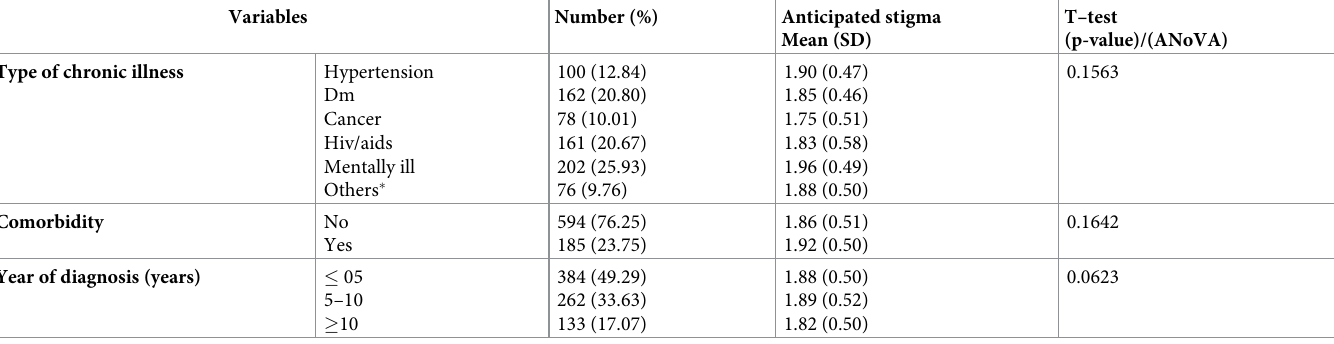
Table 3. Clinical characteristics of patients with chronic illness in three Amhara region Referral Hospitals, Northwest Ethiopia (n = 779).